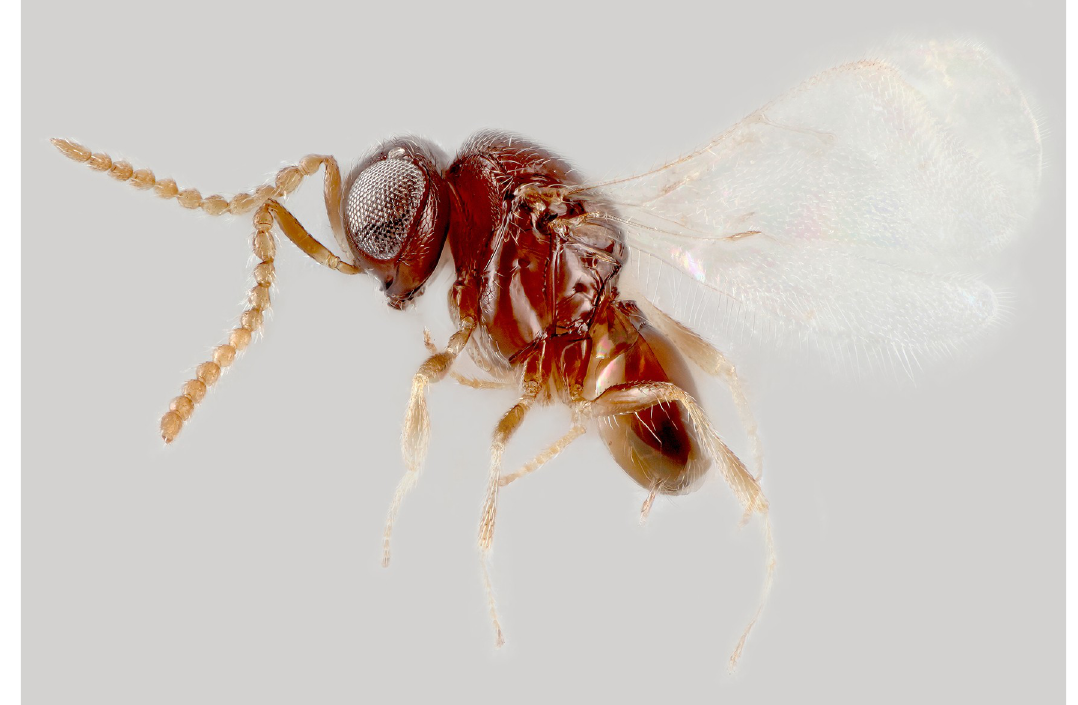
Fig 1. Telenomus nizwaensis Polaszek male holotype. Lateral